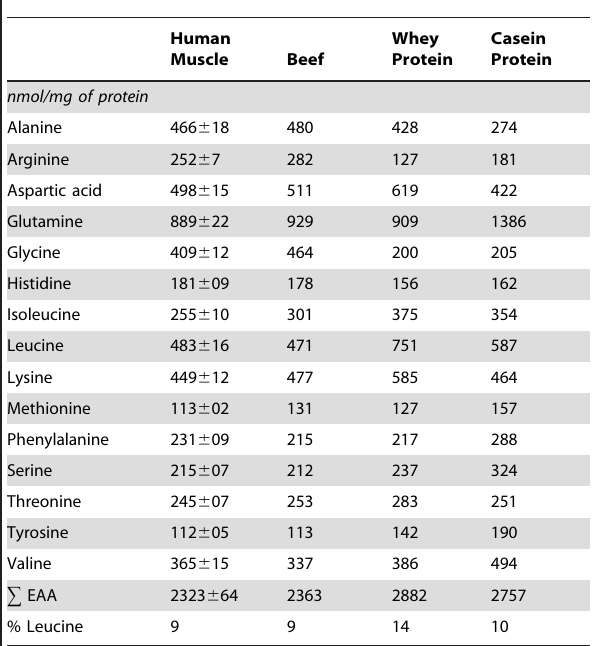
Table 3. Protein-bound amino acid concentrations in the cow organ tissues ( n =1).